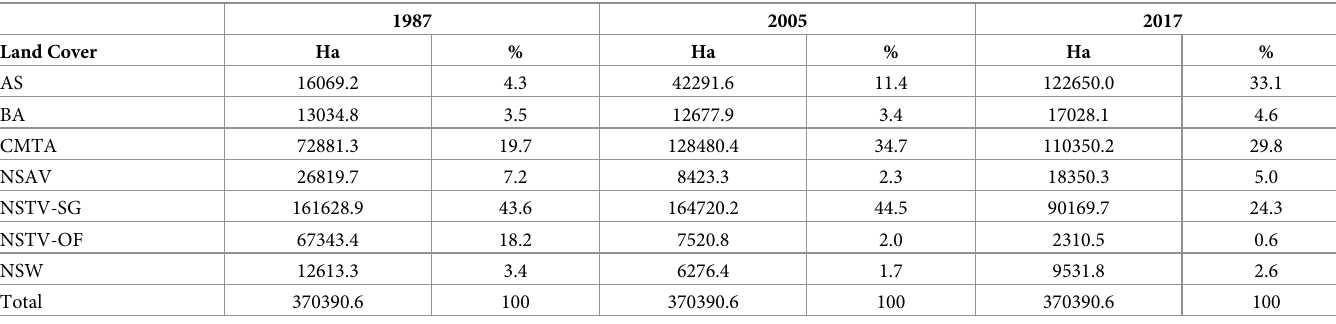
Table 3. Landcover statistics of the Greater Accra Region for 1987 to